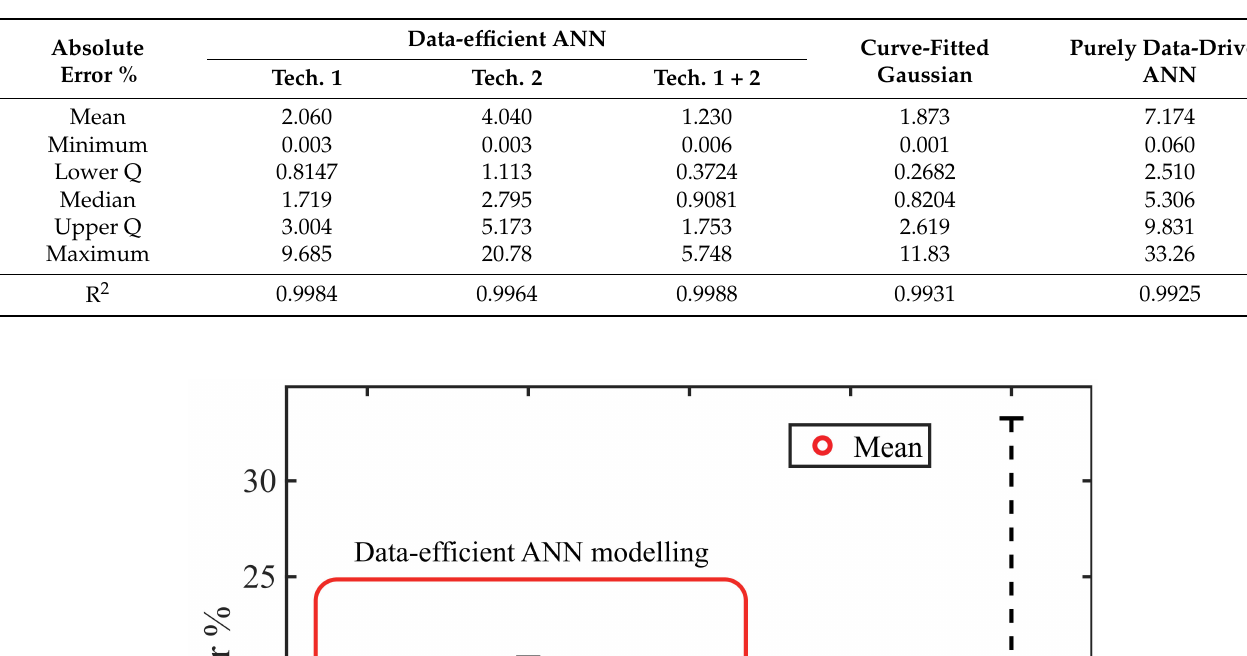
Table 2. Summary of the prediction results in absolute percent error for the testing single-track profiles in CSAM. The results are presented for: data-efficient ANN with the two techniques applied individually (Tech. 1 and Tech. 2), both applied (Tech. 1 + 2) also presented in Figure 2, curve-fitted Gaussian function model and purely data-driven ANN model. R 2 values are also listed.